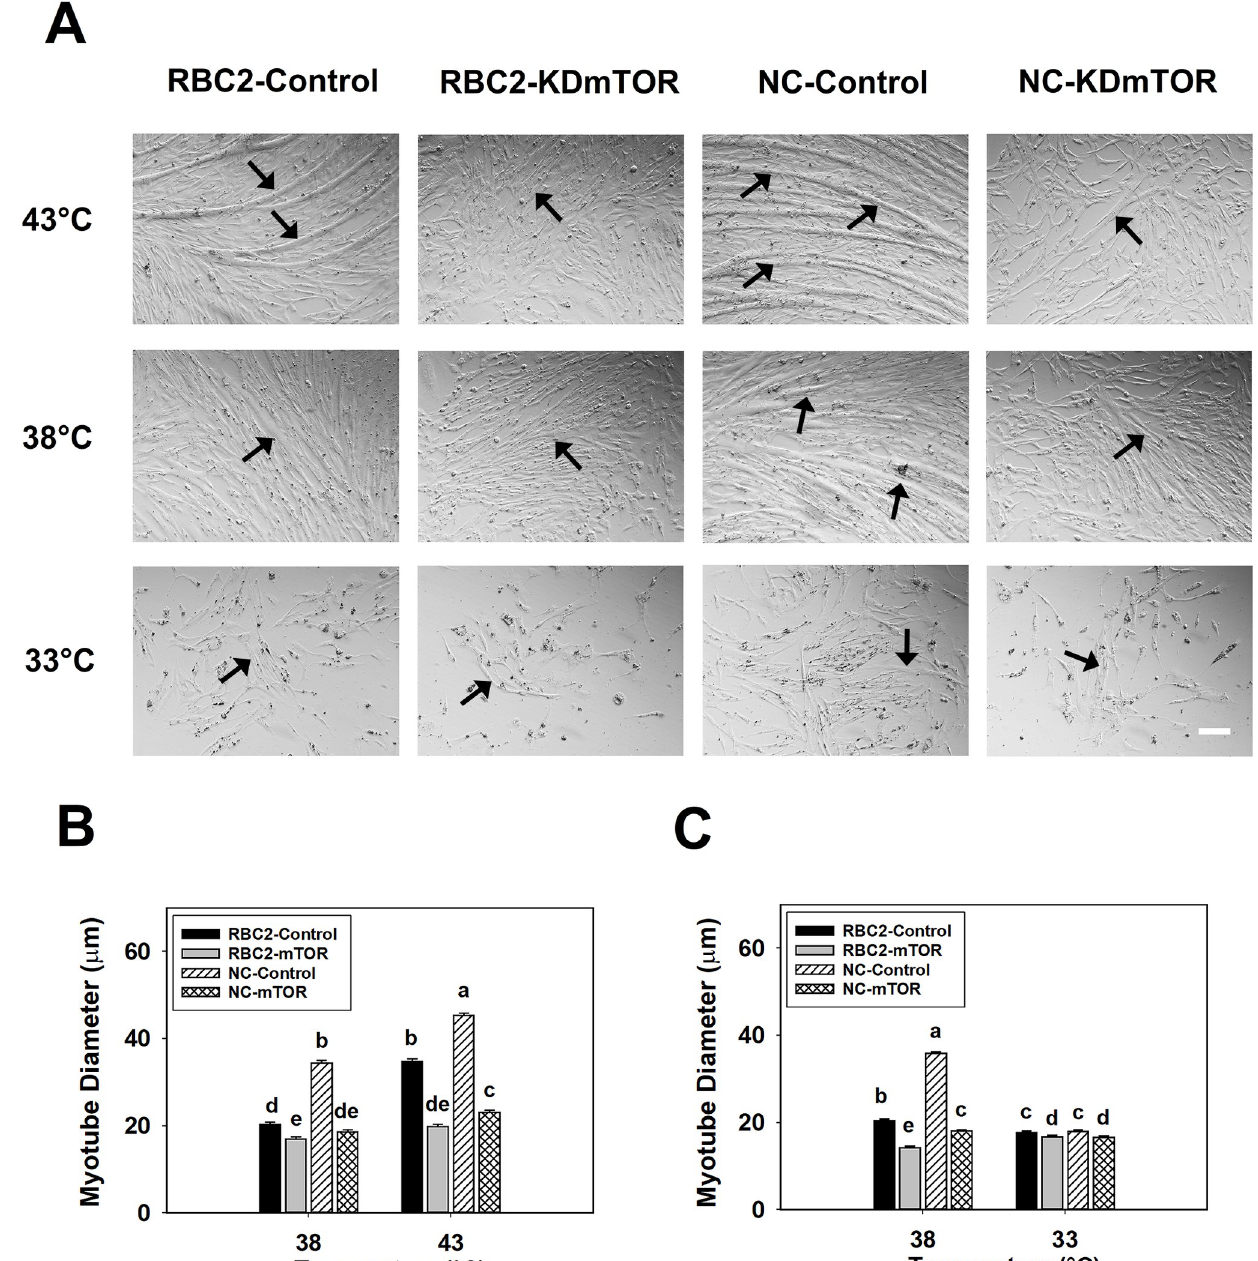
Fig 5. Effect of heat or cold thermal stress and siRNA-mediated knockdown of mTOR at the beginning of proliferation on the diameter of myotubes formed by RBC2 and NC line SCs. (A) Representative photomicrographs of SCs from the RBC2 and NC lines transfected with either a negative control siRNA (Control) or a siRNA targeting mTOR (KD mTOR) at the beginning of proliferation and followed with 72 h of proliferation and 48 h of differentiation at 38, 43, or 33˚C. (B) Diameter of myotubes in the RBC2 and NC lines at 38 or 43˚C as shown in (A). (C) Diameter of myotubes in the RBC2 and NC lines at 38 or 33˚C as shown in (A). Each graph bar represents a mean diameter of the myotubes, and each error bar represents a standard error of the mean value. Mean values with different letters are significantly different ( P � 0.05). Black arrows highlight representative myotubes. Scale bar (White) = 100 μ